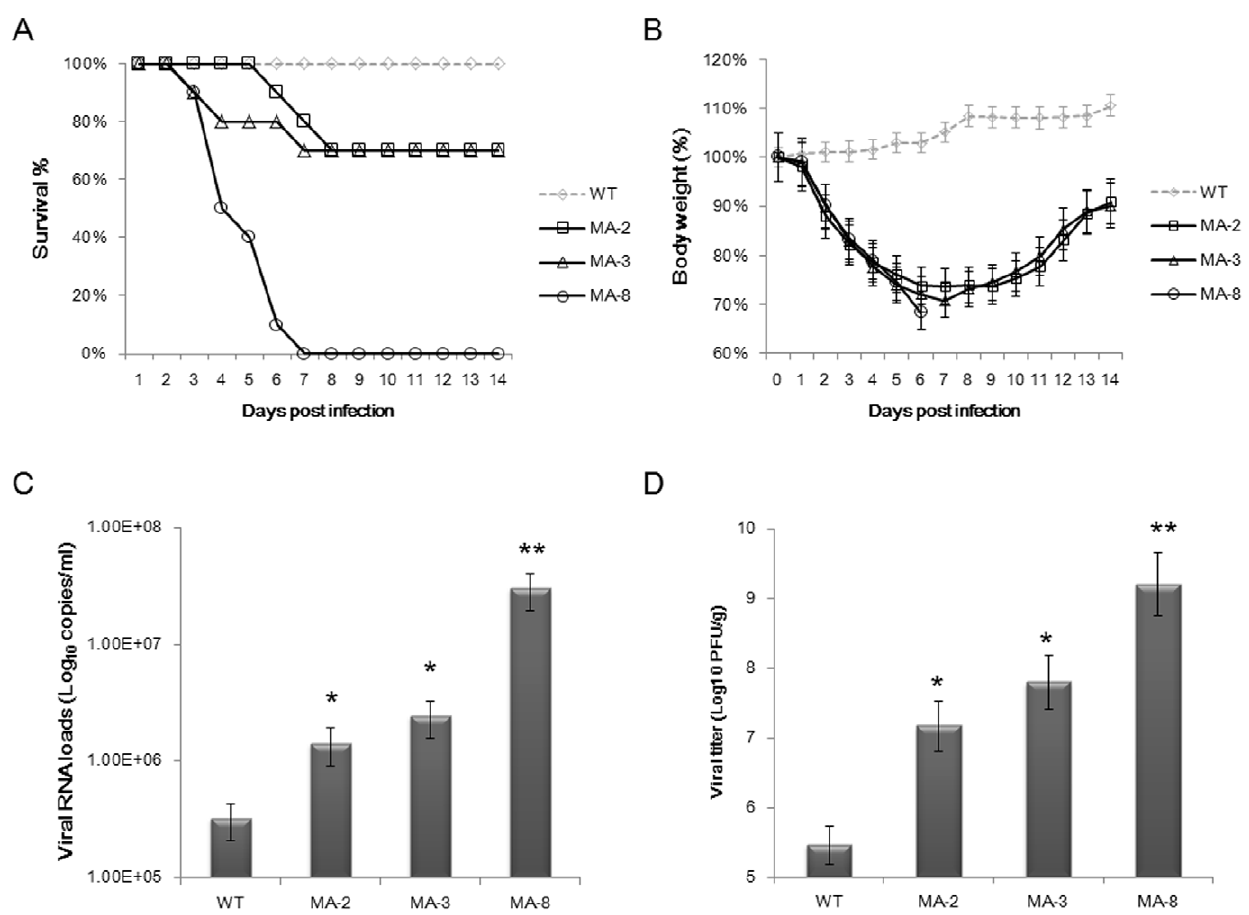
Figure 3. The pathogenicity of wild-type and mouse-adapted seasonal H1N1 A/Brisbane/59/2007 viruses in BALB/c mice. Groups of mice were inoculated intranasally with each type of virus (n=20 per group; 50 m l of 10 4.2 PFU) and ten mice were randomly selected and monitored daily for signs of disease and mortality up to 14 d.p.i. The remaining ten mice from each group were sacrificed on 4 d.p.i., and their lung tissue and bronchoalveolar lavage fluid (BALF) samples were used for determining the viral RNA and titers as well as histological examination. (A) Survival percentage of mice. (B) Body weight changes of infected mice. Data are expressed as mean % 6 SD of each group of mice relative to the value (100%) before inoculation. (C) Viral RNA loads in BALF. Data are presented as mean 6 SD of viral loads per milliliter of each group of mice. (D) Viral titers in lung tissues. Data are presented as mean 6 SD of log 10 PFU/mg from each group of mice. * P , 0.05 or ** P , 0.01 vs. the values of wild type